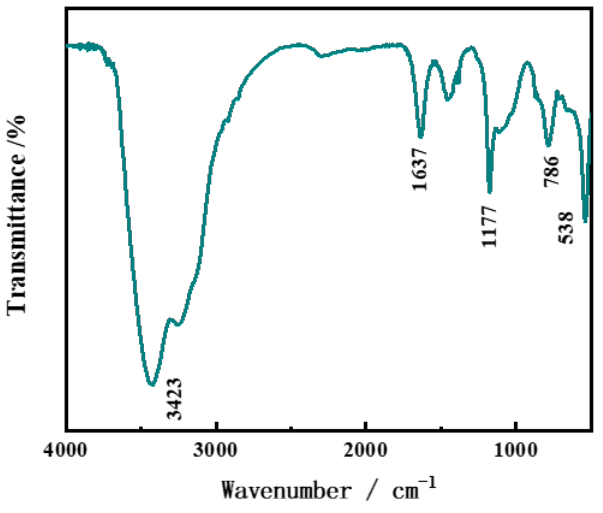
Figure 2. FTIR spectrum of hollow CoSn(OH) 6 .